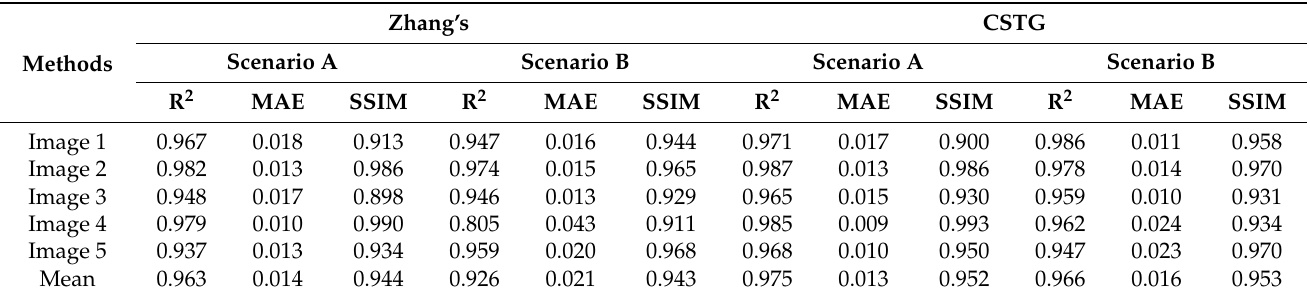
Table 4. The evaluate metrics derived by comparing the surface reflectance in all bands between the original images and the images recovered using different methods. The original images come from MOD09A1 and MOD13Q1,